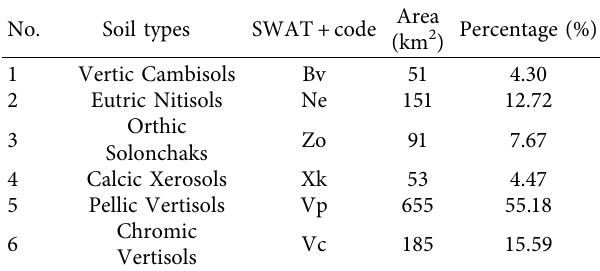
Table 2: Te dominant soil classes in the study area and their SWAT +codes.